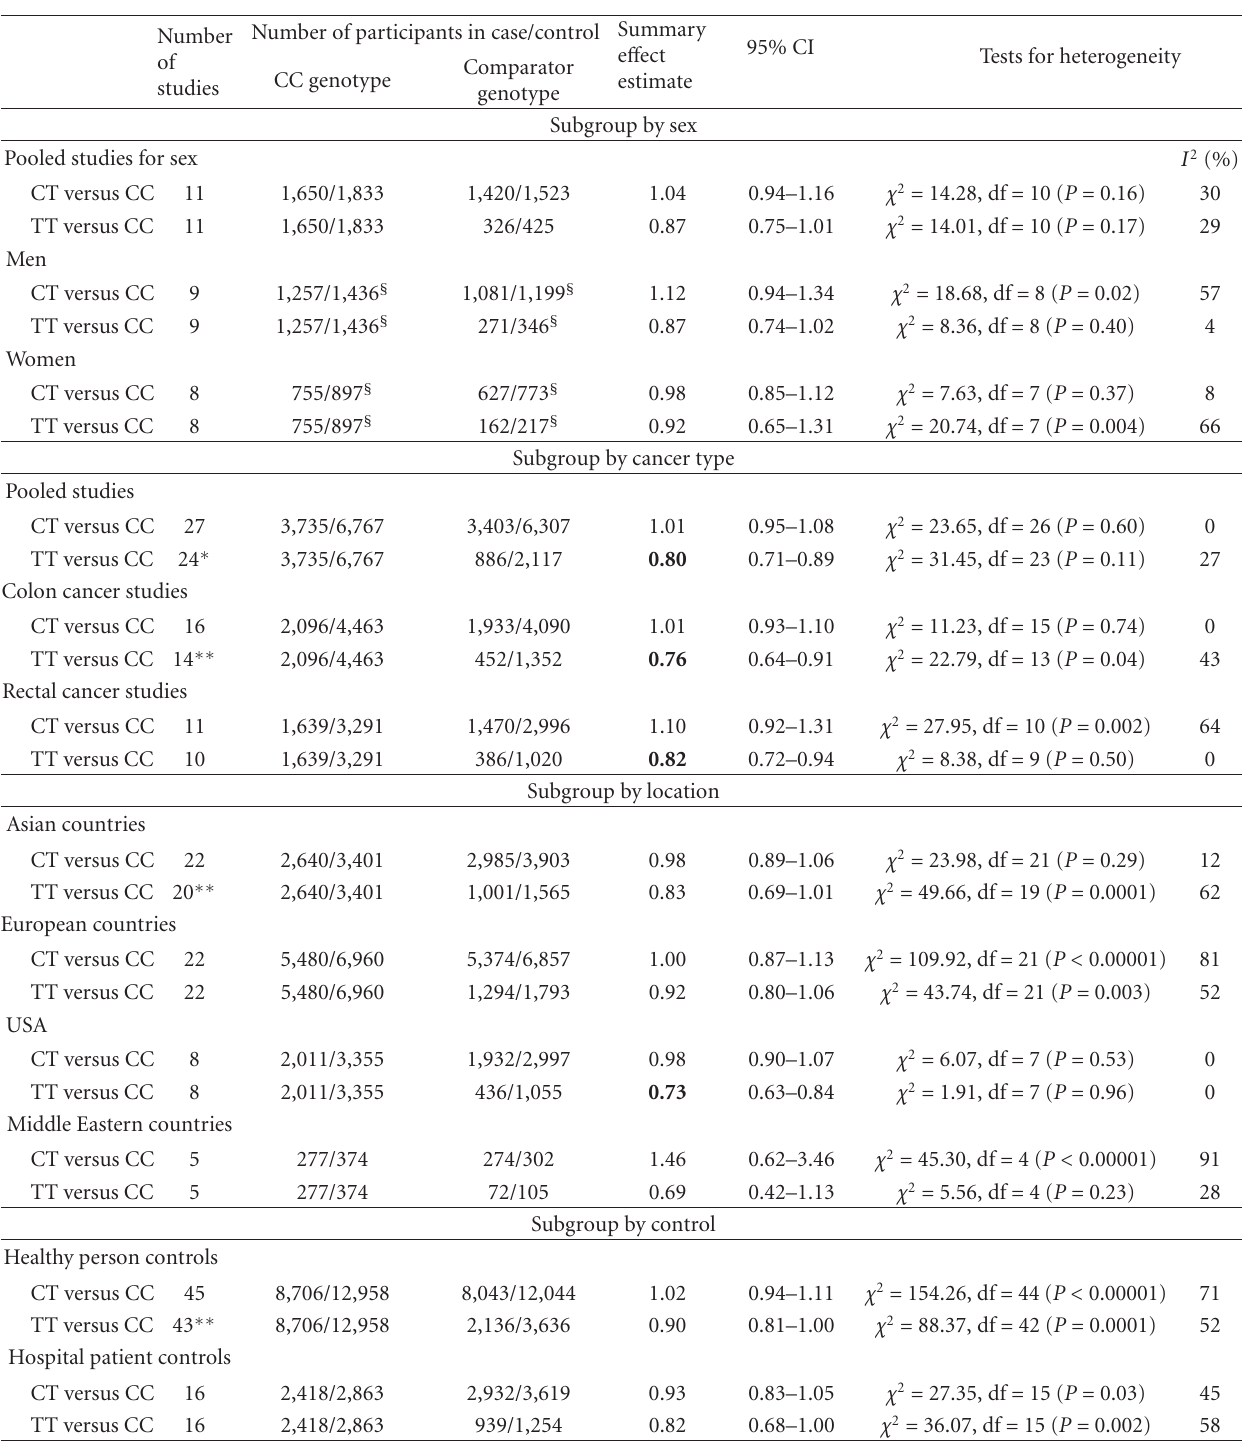
Table 2: Subgroup analysis for the MTHFR C677T